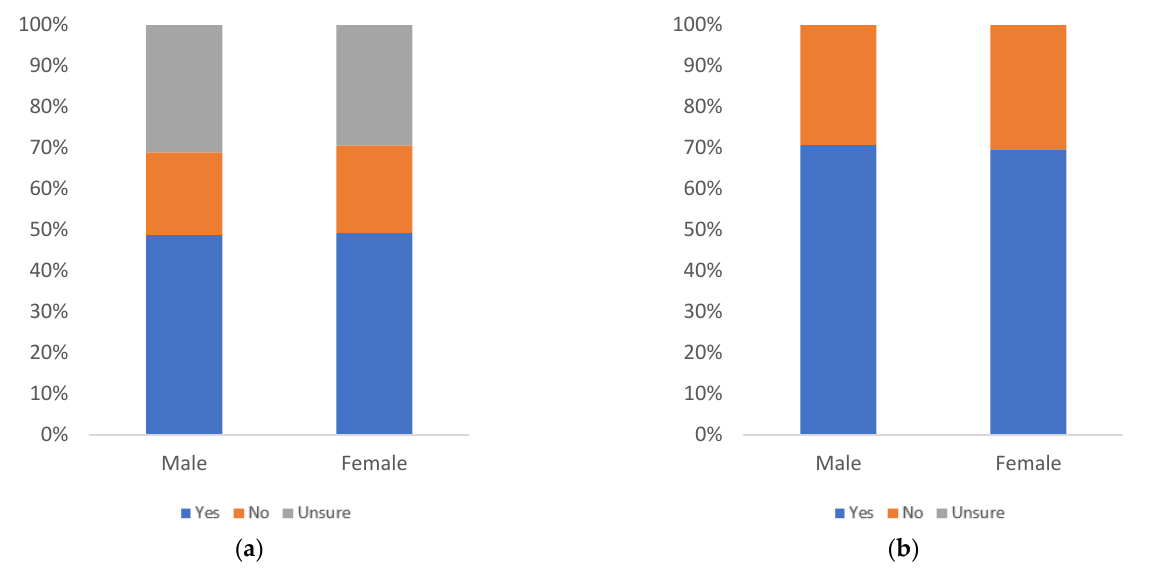
Figure 32. Label others’ use, by gender: ( a ) with uncertain respondents (left) and ( b ) without uncertain respondents (right).